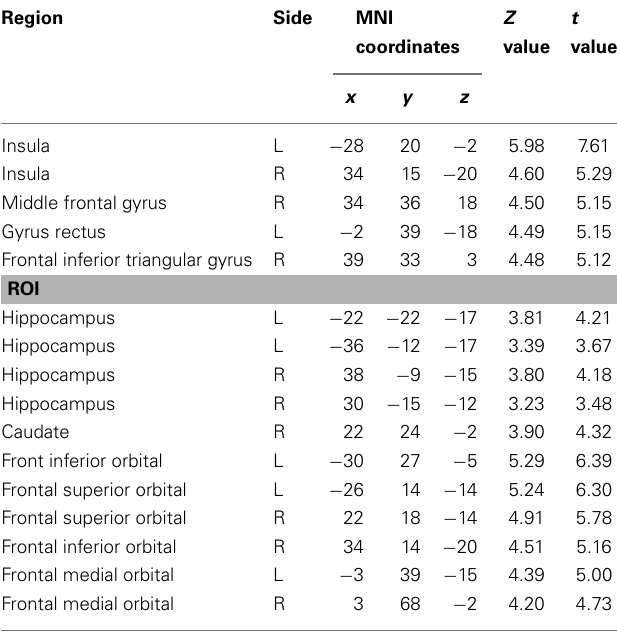
BEHAVIORAL NAVIGATION SCORES Table 2 | Reductions of GM volume in patients with schizophrenia compared to healthy controls (controls >